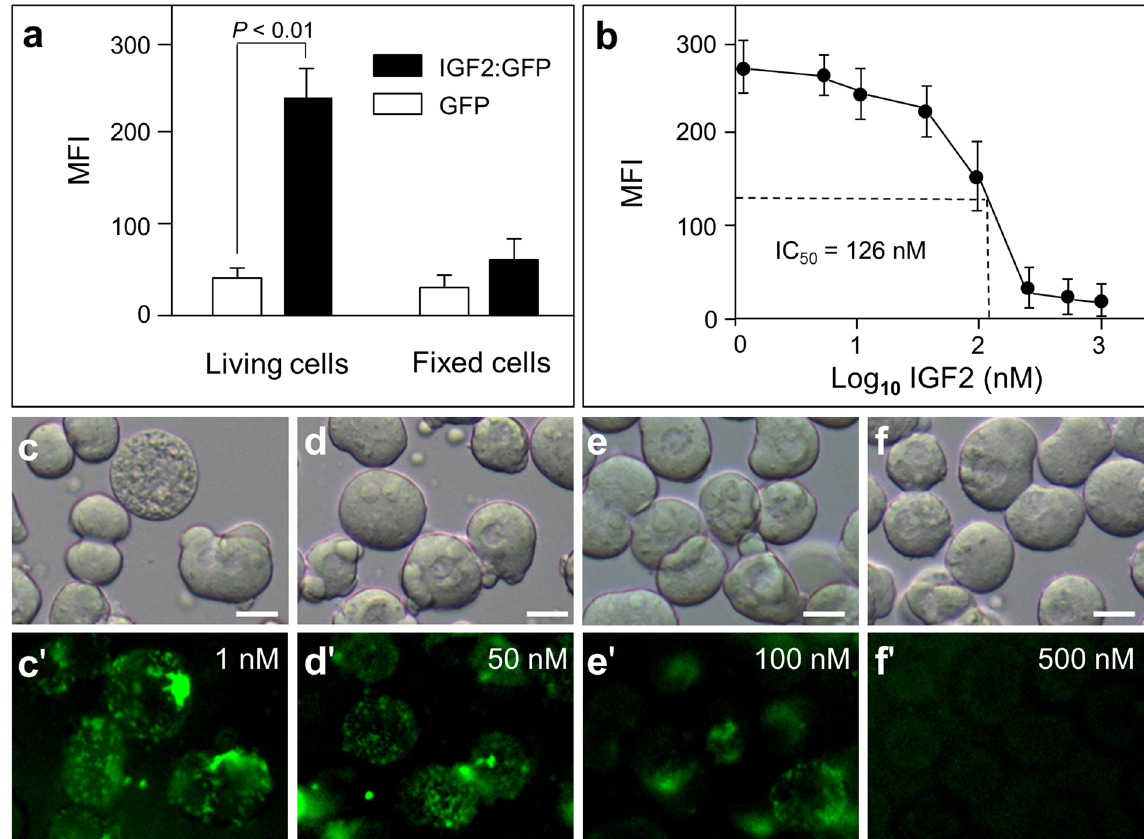
Figure 5. IGF2:GFP binds to madaka blastomeres. ( a ) Relative binding ability of IGF2:GFP. Live or fixed medaka blastomeres were incubated with IGF2:GFP. MFI in micrographs was calculated to evaluate the binding ability of IGF2:GFP comparing to control protein GFP. ( b ) Competitive binding assay. Blastomeres were co- incubated with IGF2:GFP (200 nM) and IGF2 at indicated concentration. Fluorescence intensity was measured to determine the competitive binding curve. ( c–f ′ ) Phase contrast and fluorescence micrographs of blastomeres representing the competitive binding of IGF2:GFP and IGF2 at indicated concentration. Top, phase contrast; bottom, fluorescence optics. Scale bars, 5 μ